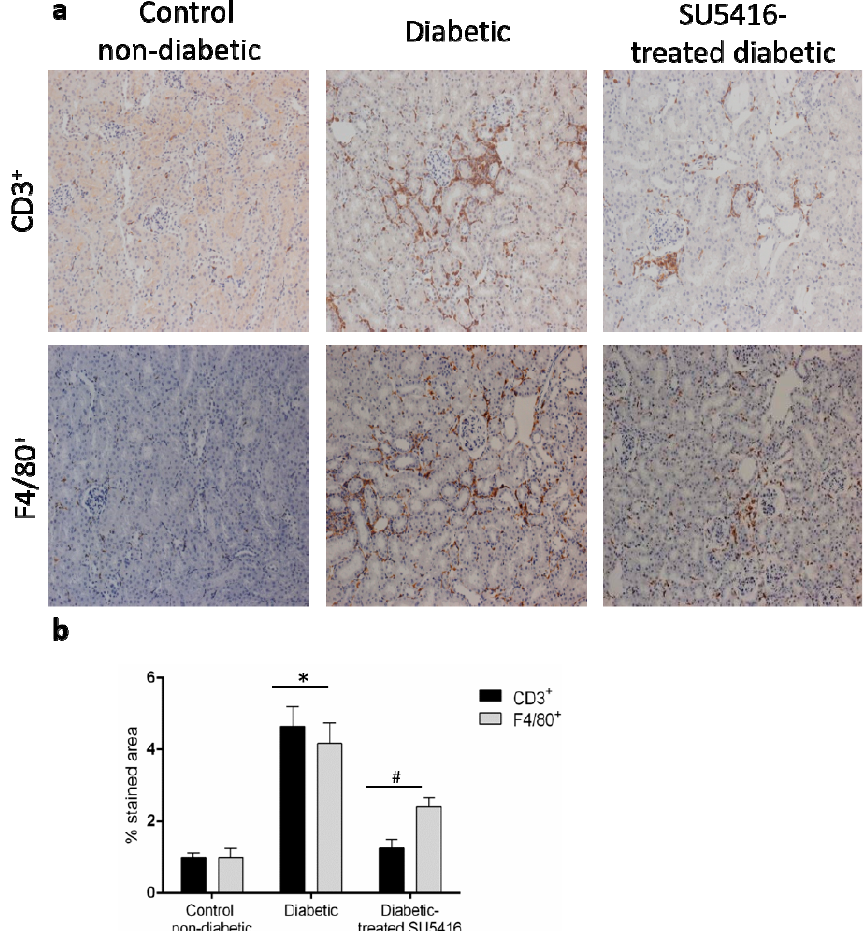
Figure 6. A VEGFR2 blockade inhibited renal-inflammatory responses in the BTBR ob/ob experimental model. ( a ) Quantification of F4/80+, CD3+, and CD4+ cells as described in the Methods section, as an n-fold change of positive staining versus total area, normalized by values of control mice and data of each animal and mean ± SEM. ( b ) Representative images of the immunohistochemistry for non-diabetic, diabetic and SU5416-treated diabetic animals. Magnification ×200. Bars = 20 µm. Data as mean ± SEM of 6–8 mice per group. * p < 0.05 versus control non-diabetic, # p < 0.05 versus diabetic.